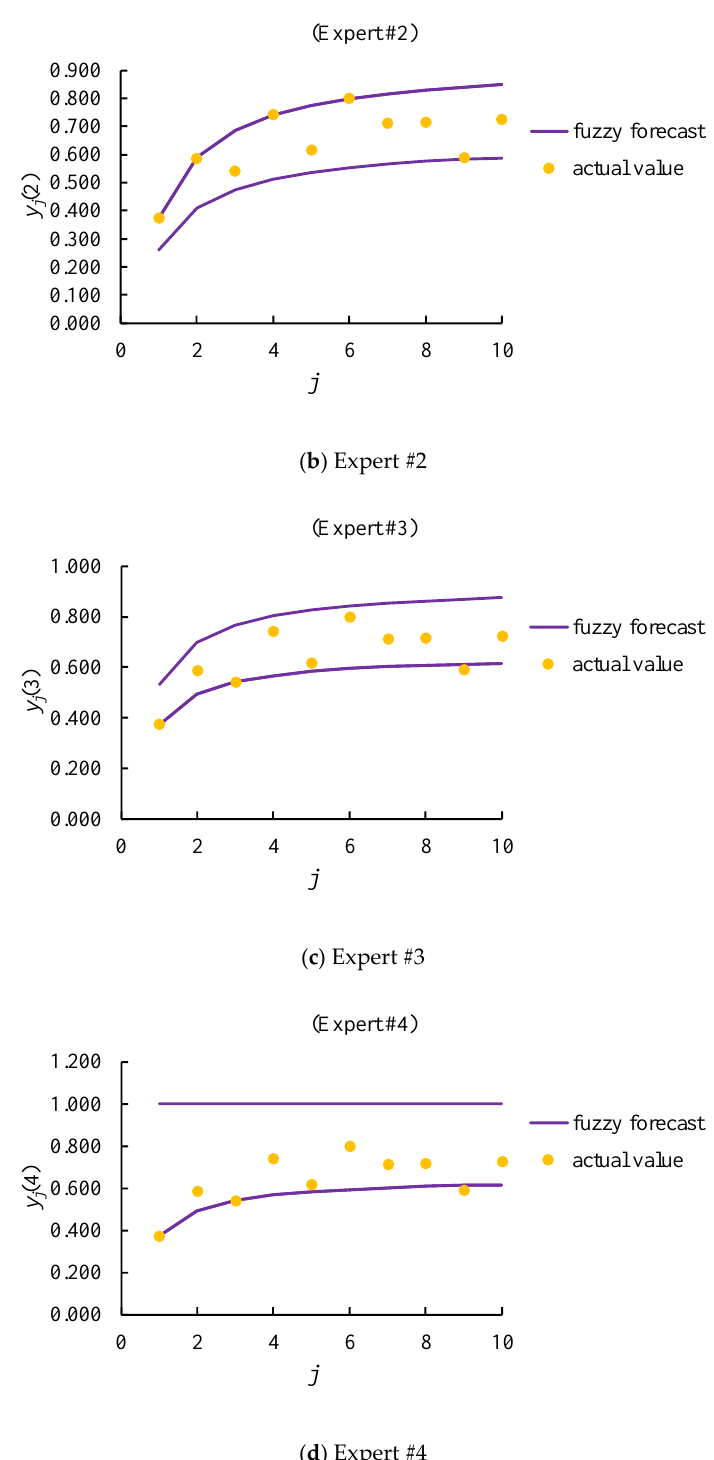
Figure 7. Expert dynamic random access memory (DRAM) yield forecasts.